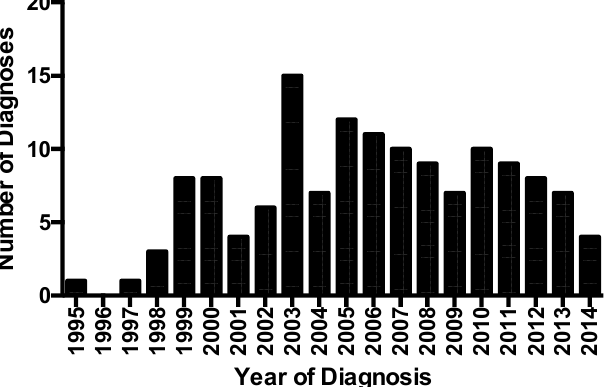
Figure 1. Annual diagnoses of habit cough by the faculty of the University of Iowa Allergy and Pulmonary Clinic from 1995 to